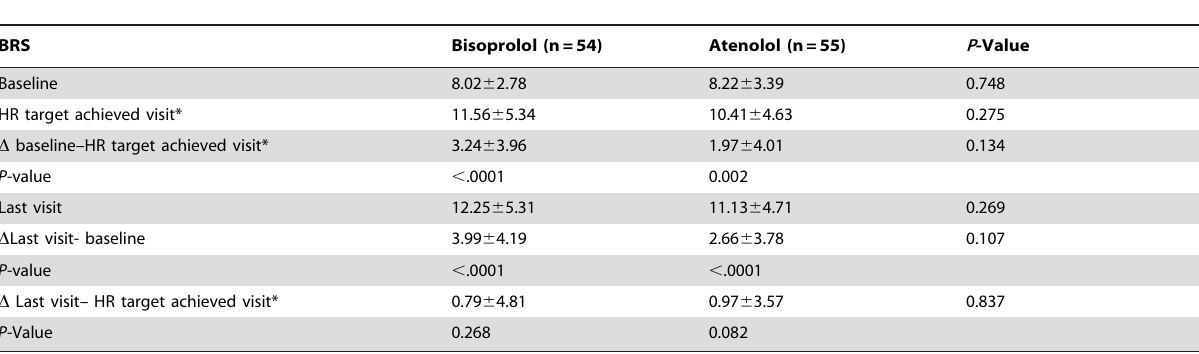
Table 3. Changes in BRS from baseline to the end of treatment in the bisoprolol and atenolol groups